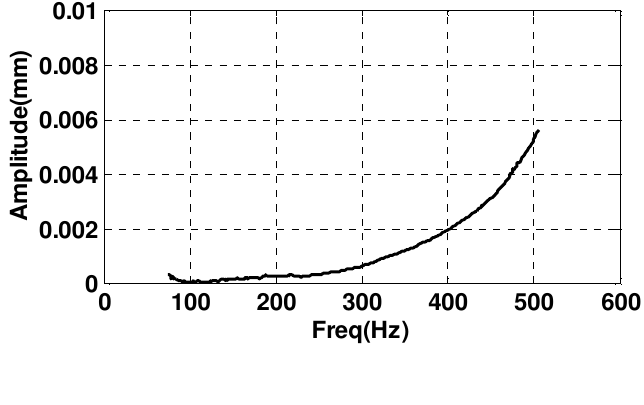
Figure 22. Amplitude of rotor’s synchronous displacement after field balancing with the rotation speed decreasing from 500 Hz to